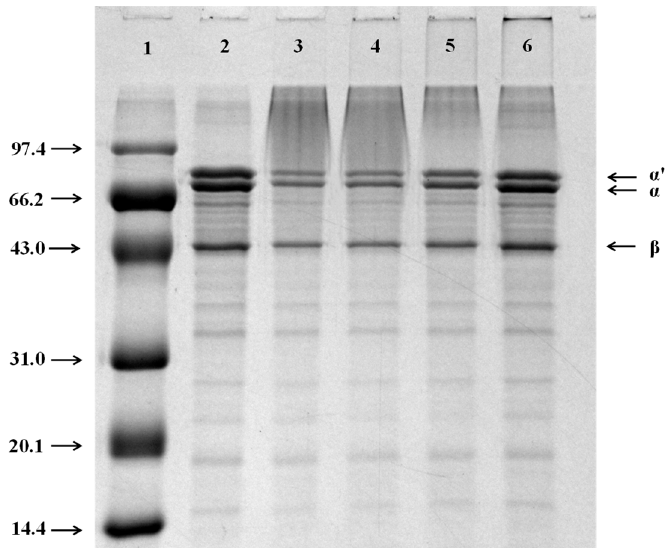
Figure 1. SDS-PAGE profiles of 7S and 7S-DEX conjugates obtained at 60 °C and RH 79%. Lanes: 1, Maker; 2, native 7S; 3, 7S-40; 4, 7S-70; 5, 7S-150; 6, 7S-500. 7S: soy β -conglycinin; DEX: dextran; 40: dextran (40 kDa); 70: dextran (70 kDa); 150: dextran (150 kDa); 500: dextran (500 kDa).